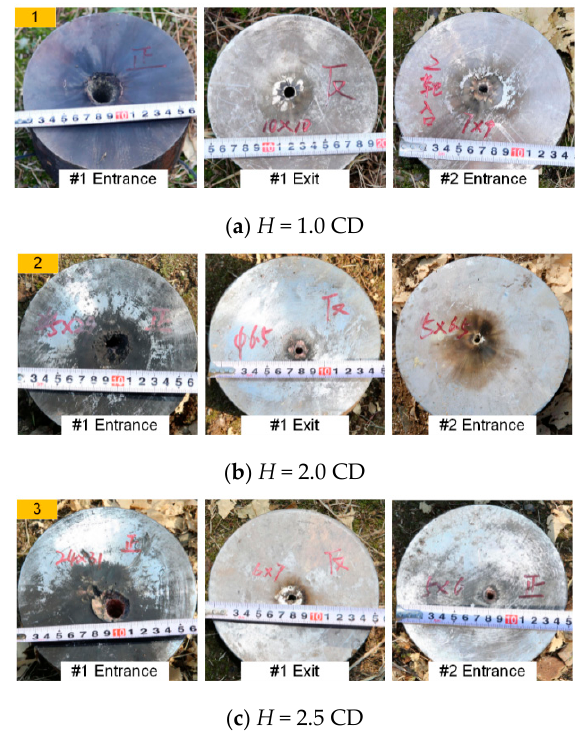
Figure 5. Typical experiments of RM-CL shaped charge with a 3-mm reactive liner.